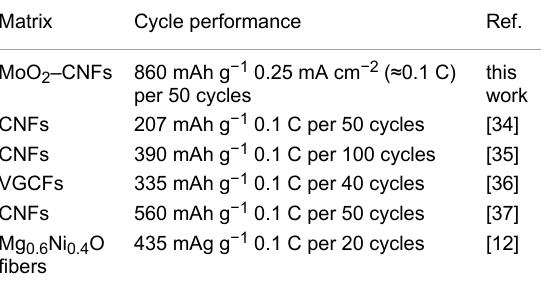
MoO 2 –CNFs improve the electrochemical reaction kinetics during the charge–discharge process.